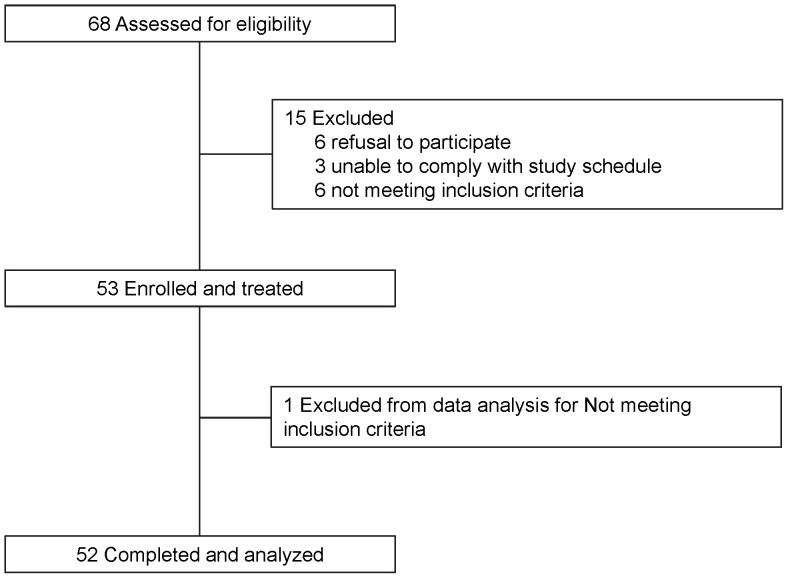
Study flow diagram.